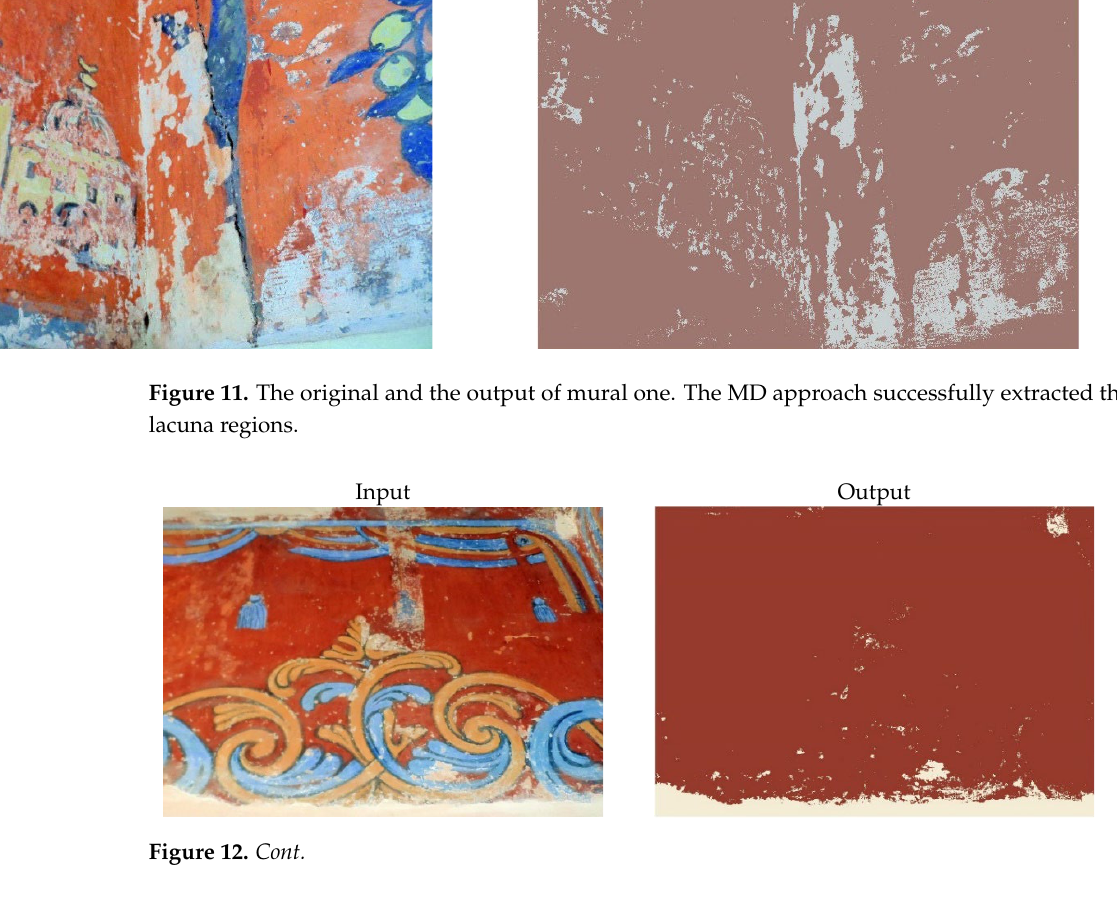
Figure 10. The original and the results of enhancing of murals 2, 3, 4, 5, and 6 using DCP.